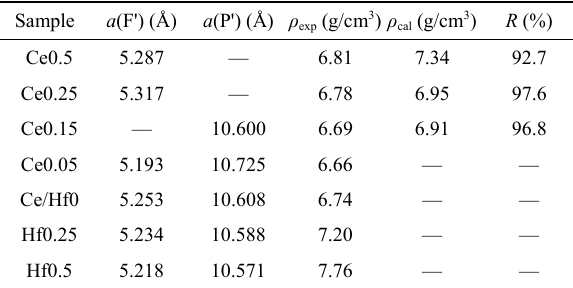
Table 2 Structural information of A 2 B 2 O 7 high-entropy